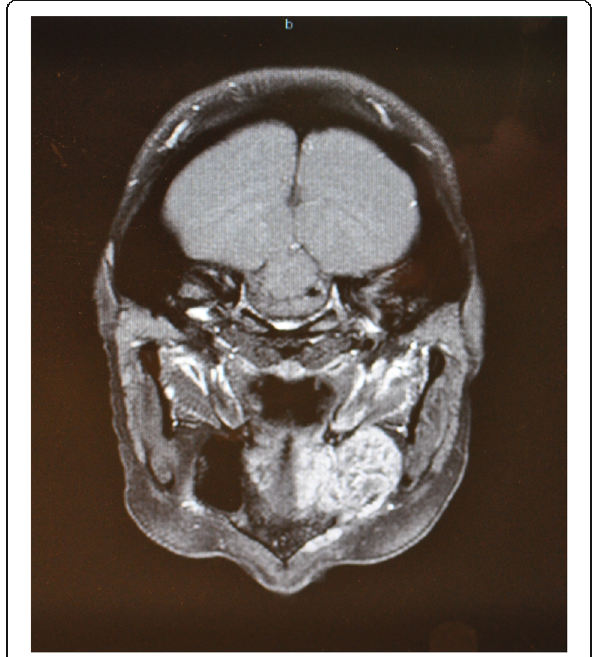
Fig. 6 Pt no. 2. Transverse plane of the preoperative CT scan showing a radiopaque mass of the left maxilla